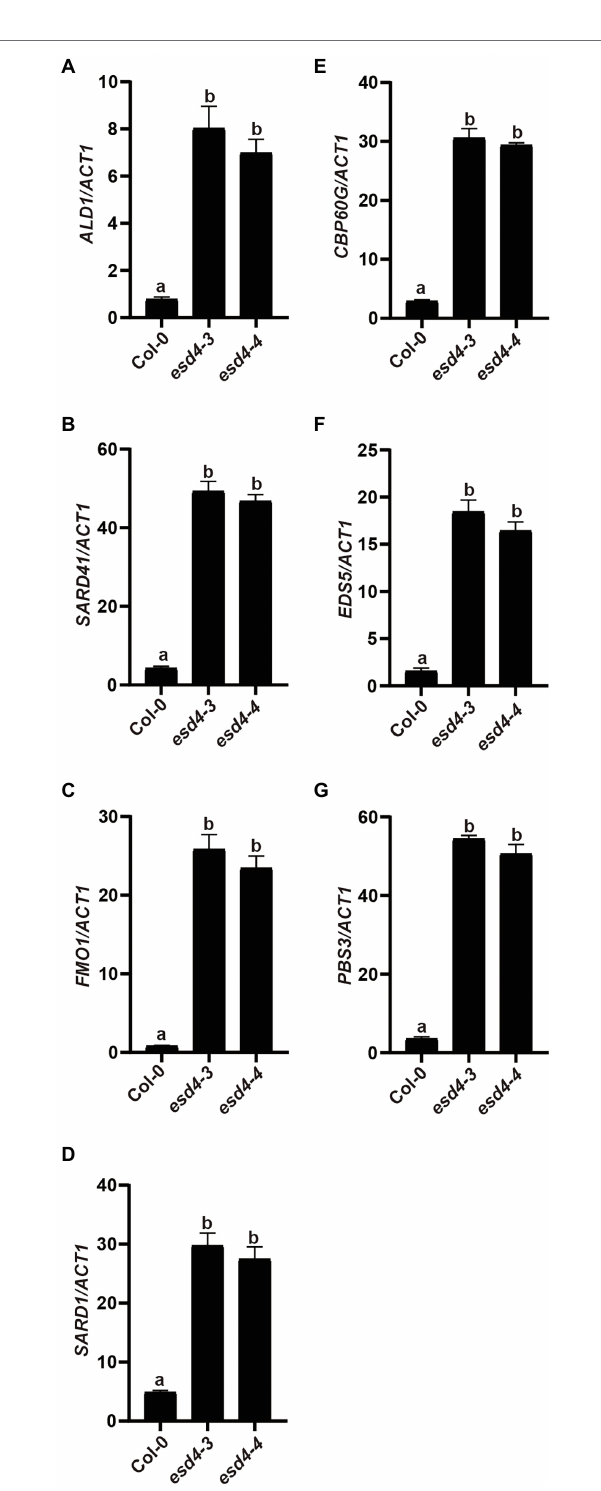
FIGURE 4 | NHP and SA biosynthesis genes are upregulated in esd4 mutant. qRT-PCR was used to examine the NHP biosynthesis genes (A-C) , SARD1 (D) , CBP60g (E) and SA biosynthesis genes (F,G) on three-week-old Col-0, esd4-3 and esd4-4 plants. ACTIN1 serves as internal control. Error bars represent standard deviations. Letters indicate statistical differences ( p < 0.05, one-way ANOVA, n =